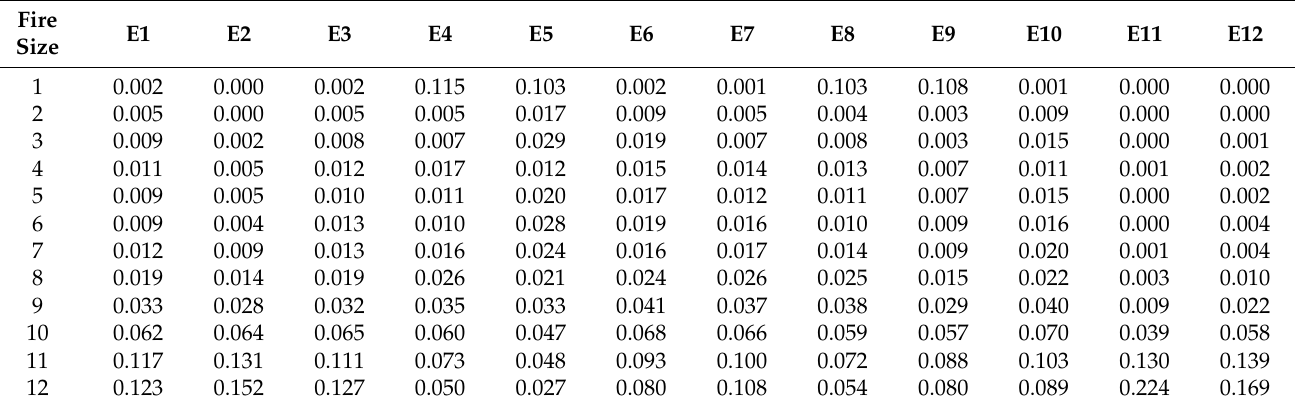
Table 5. The results of fire scale probability of occurrence caused by the initial fire position of each equipment unit.